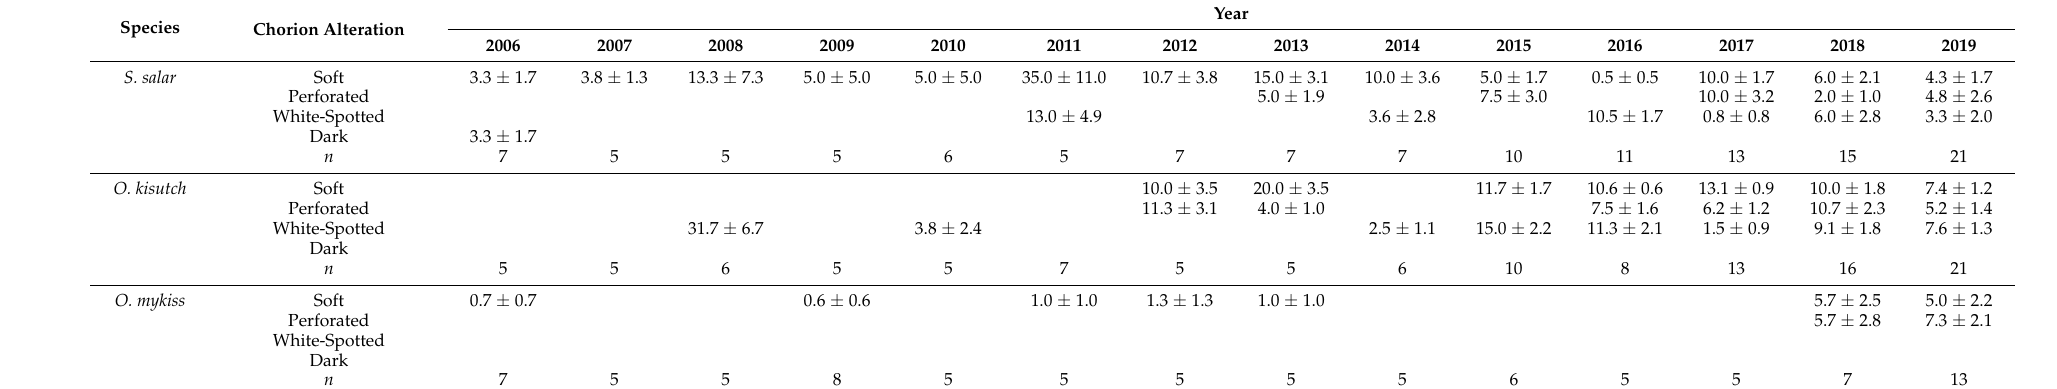
Table 1. Occurrence rate (%) of characterized chorion